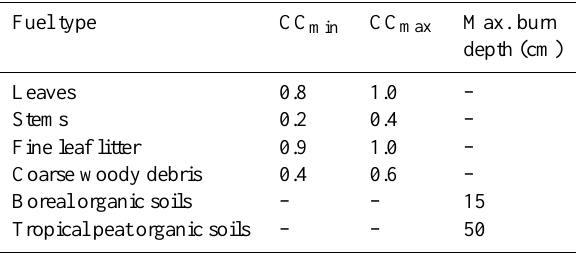
Table 1. Minimum and maximum combustion completeness (CC, unitless) or maximum burn depth for different fuel types